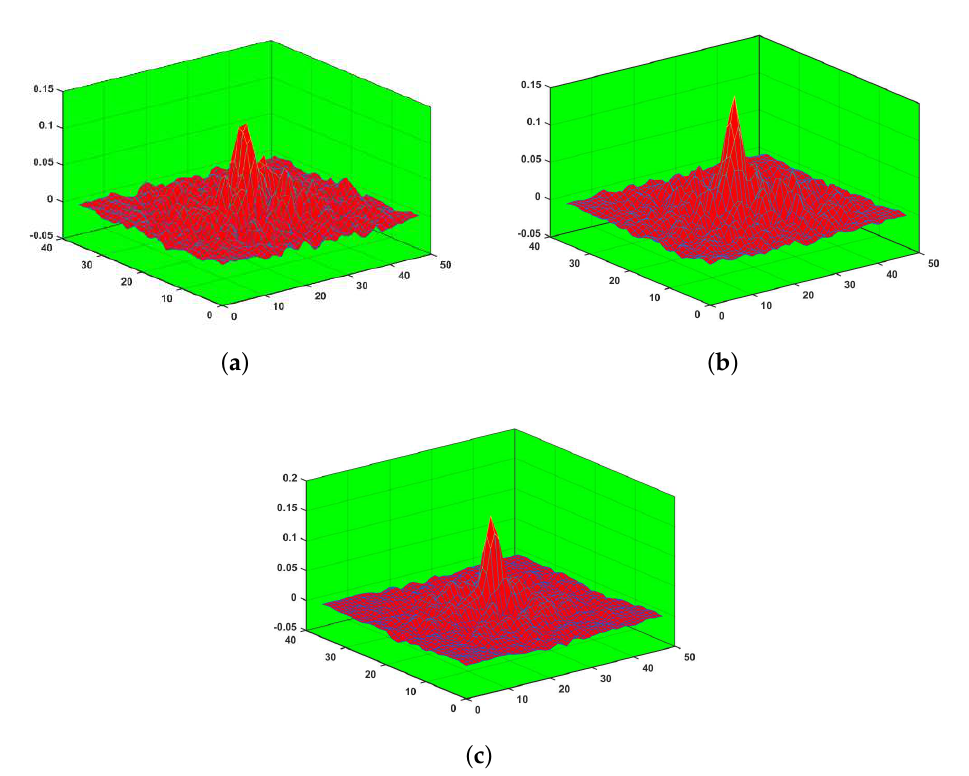
Figure 2. Response diagram of tracking results: ( a ) Response diagram of the 6th frame image; ( b ) response diagram of the 12th frame image; ( c ) response diagram of the 31st frame